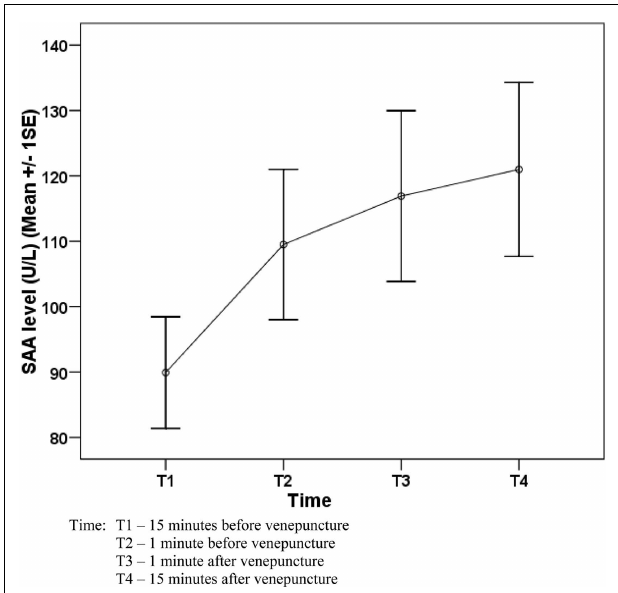
Table 3 | Change in SAA (T3–T1) among participants categorized by